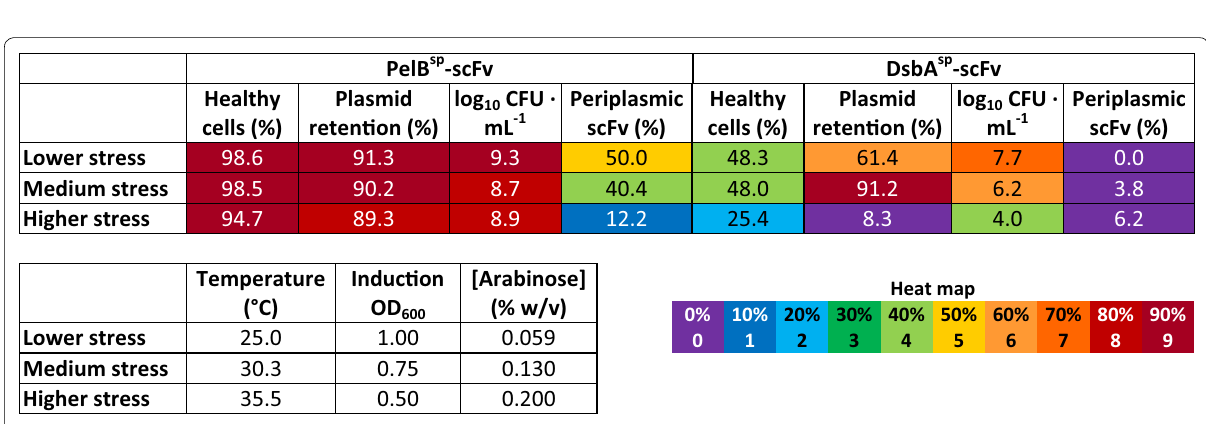
Fig. 5 Heatmap of responses from the DsbA sp -scFv and PelB sp -scFv systems that did not produce significant